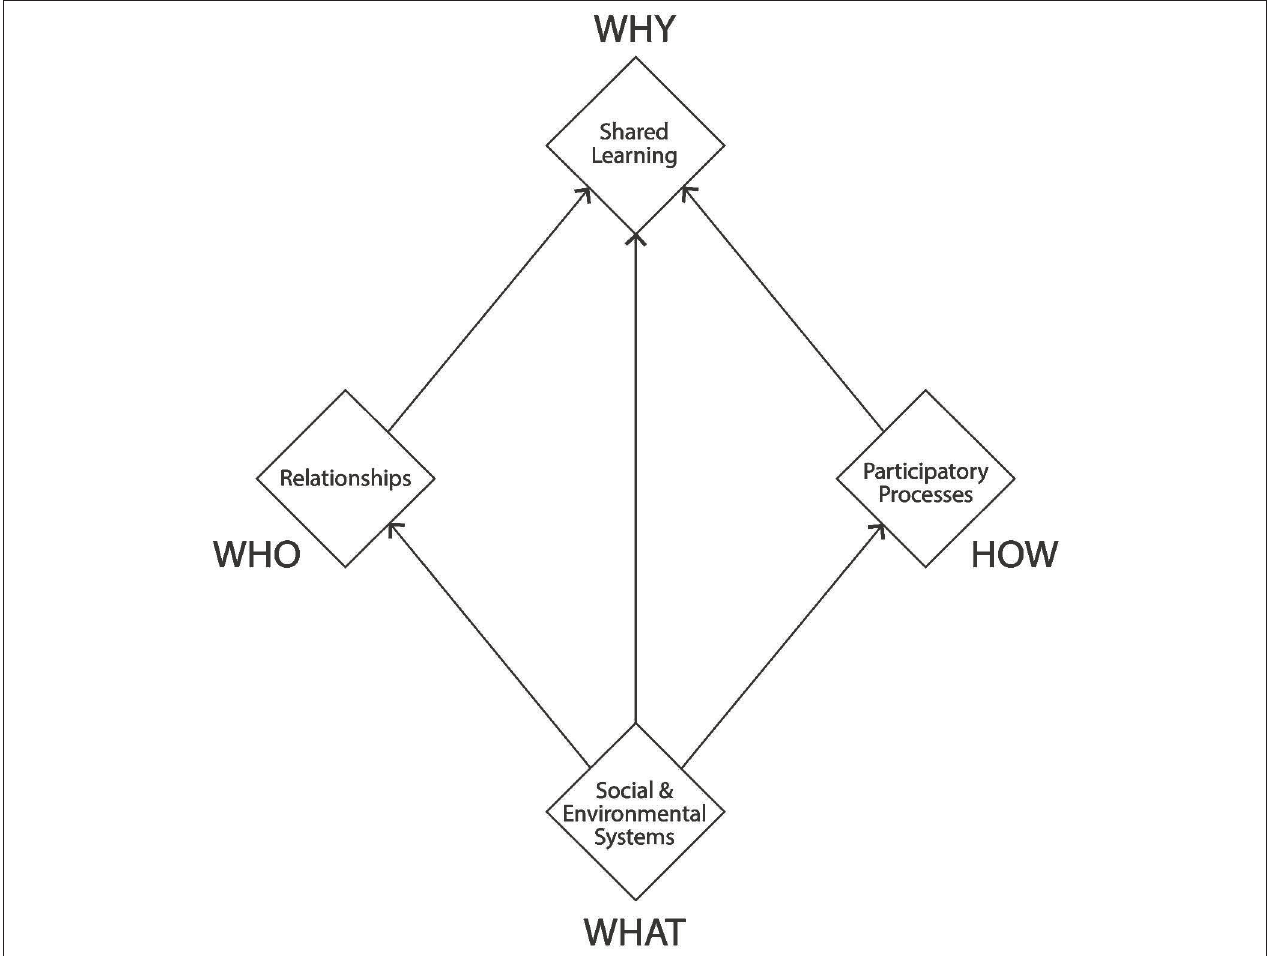
FIGURE 2 | Visualization of coded themes from evaluation responses. Inductive coding elucidated four main themes from the surveys: social and environmental systems, relationships, participatory processes, and shared learning. The content of these themes corresponded to “what,” “who,” “how,” and “why” themes in code books previously developed by Cadieux et al.